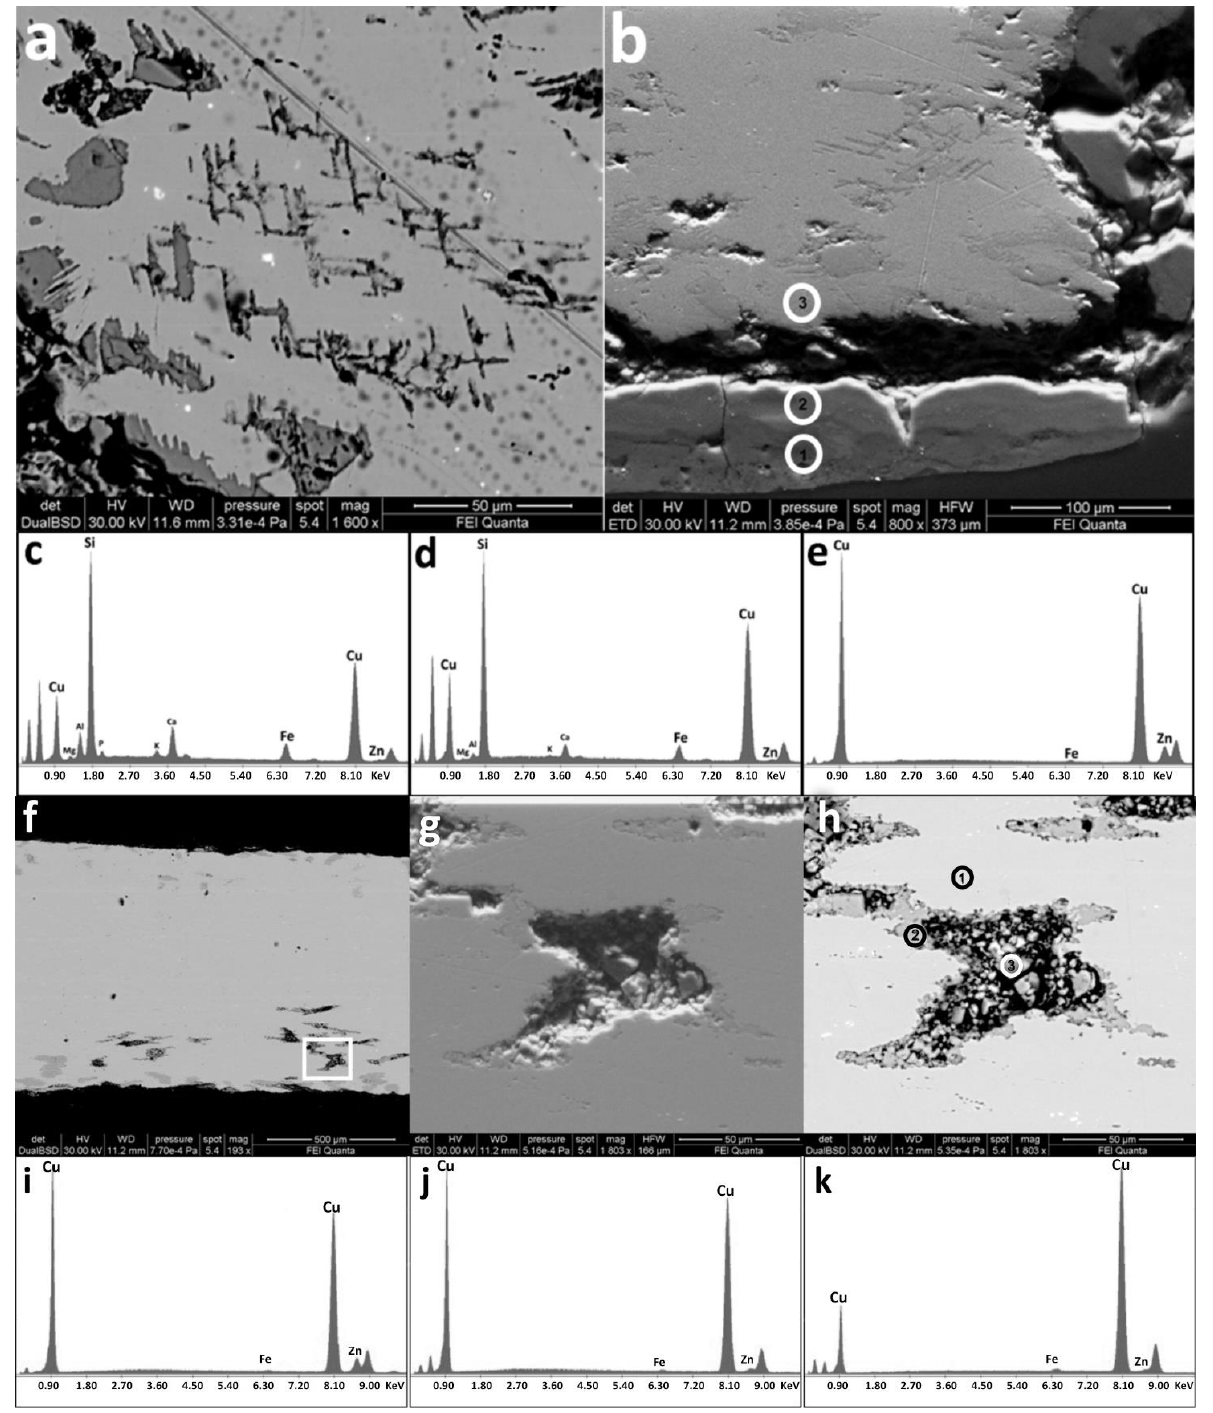
Figure 6. SEM images of the lower edge of sample F13 and relative spectra. In particular, a homogeneous and compact patina of ~60 µm occurred ( b ). EDS analyses ( c – e ) revealed that a dezincification process had occurred on the external area, whereas in the inner area Zn was still present. In addition, exogenous elements were in it. Porosity was also present near the edge ( f – h ). BSE ( a ) and SE ( b ) high magnification images of sample F13; ( c ) EDS spectrum of point “1” in image ( b ); ( d ) EDS spectrum of point “2” in image ( b ); ( e ) EDS spectrum of point “3” in image ( b ); ( f ) BSE cross section images of sample F13, the highlighted area in ( f ) is expanded in ( g ) SE image and ( h ) BSE image. EDS spectra from ( i – k ) are related to points 1, 2 and 3 respectively, highlighted in ( h ).